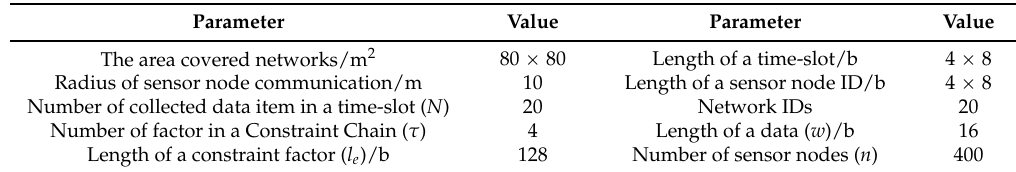
Table 1. Experiment parameters.